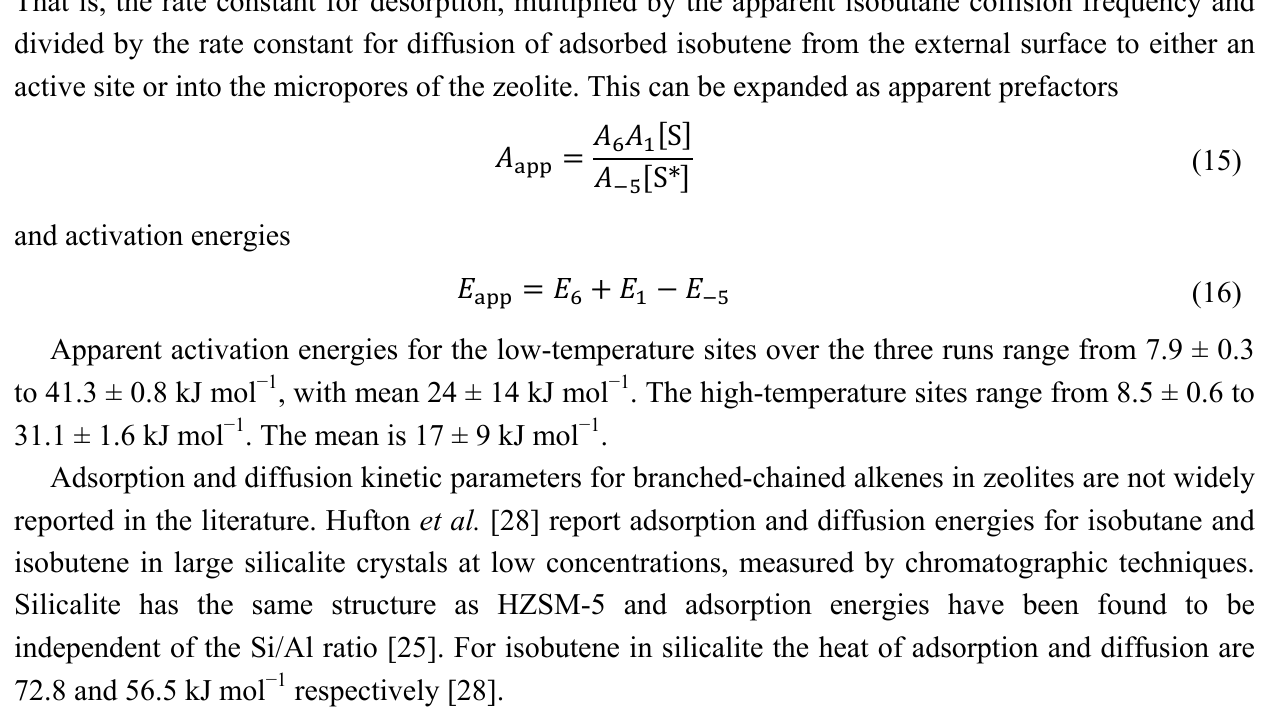
) and collision frequencies (cid:2874) (cid:3404) 0 , and the ratio log (cid:1827) : (cid:1827) (cid:3406) (cid:2869) (cid:2869)(cid:2868) (cid:2874) (cid:2879)(cid:2873)